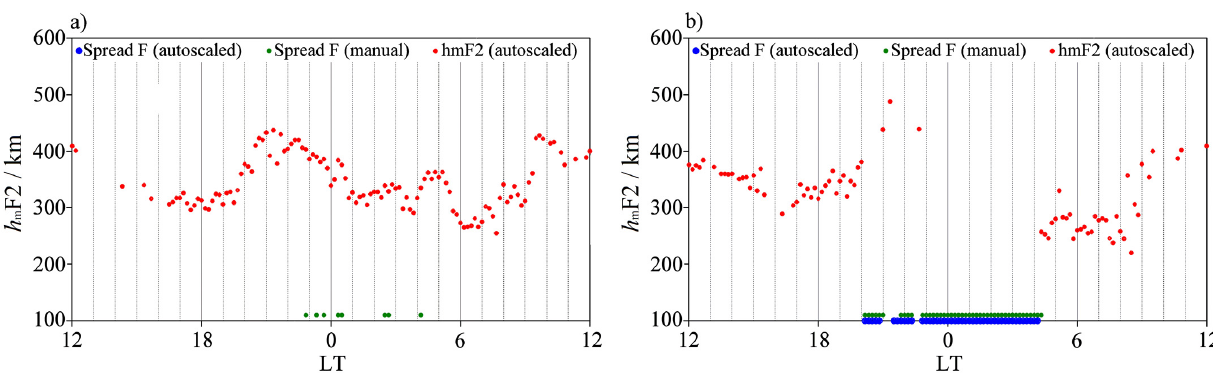
Figure 8. Graphs of h m F2 as a function of LT considering: ( a ) a case in which spread F was not detected by Autoscala (6 January 2014); and ( b ) a case in which spread F was detected by Autoscala in more than 25% of the ionograms (5 January 2014).